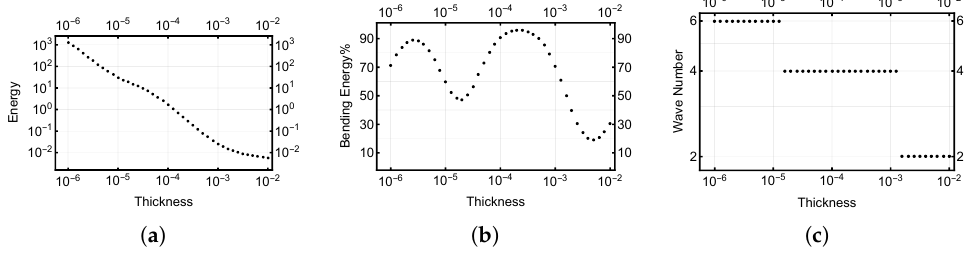
Figure 13. Case EHEH: ( a ) E ( u ) . ( b ) B ( u ) . ( c ) Angular wave number. Another interesting (and new) observation is the connection between the relative amount of bending energy and the wave number. Instead of being constantly in a pure bending state, the shells transition from one dominant wave number to another via a special state where bending is more restricted. The explanation is not easy to see, however. In fact, there exists a critical thickness at which both oscillations are simultaneously equally strong since the transition must be smooth, and this the only mechanism that can deliver the effect. This is well-known from the theory of free vibration of shells of